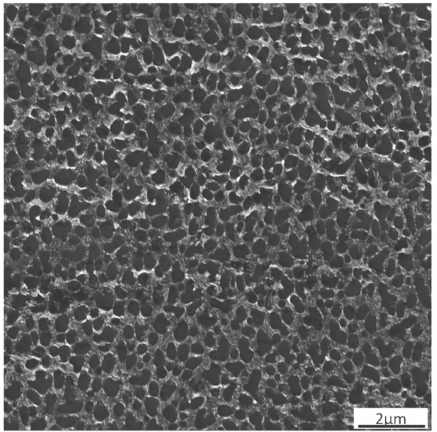
Figure 5. Hypoeutectic-like dendritic and interdendritic eutectic structure from Experiment #5 (Table 1) with Ce